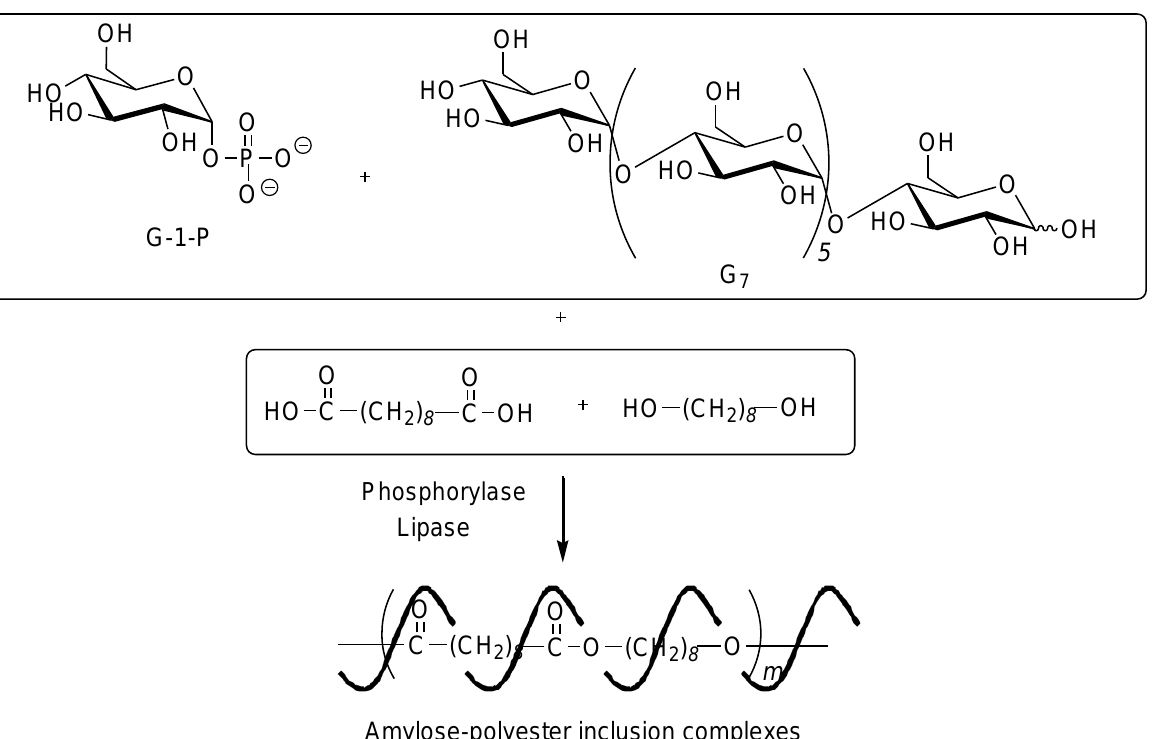
Figure 9. Formation of inclusion complexes composed of amylose and strongly hydrophobic polyester in parallel enzymatic polymerization